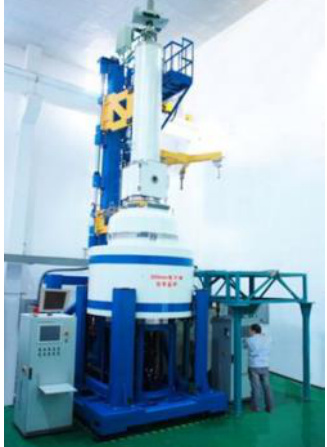
Figure 7. TDR-150 Czochralski single-crystal growth furnace.